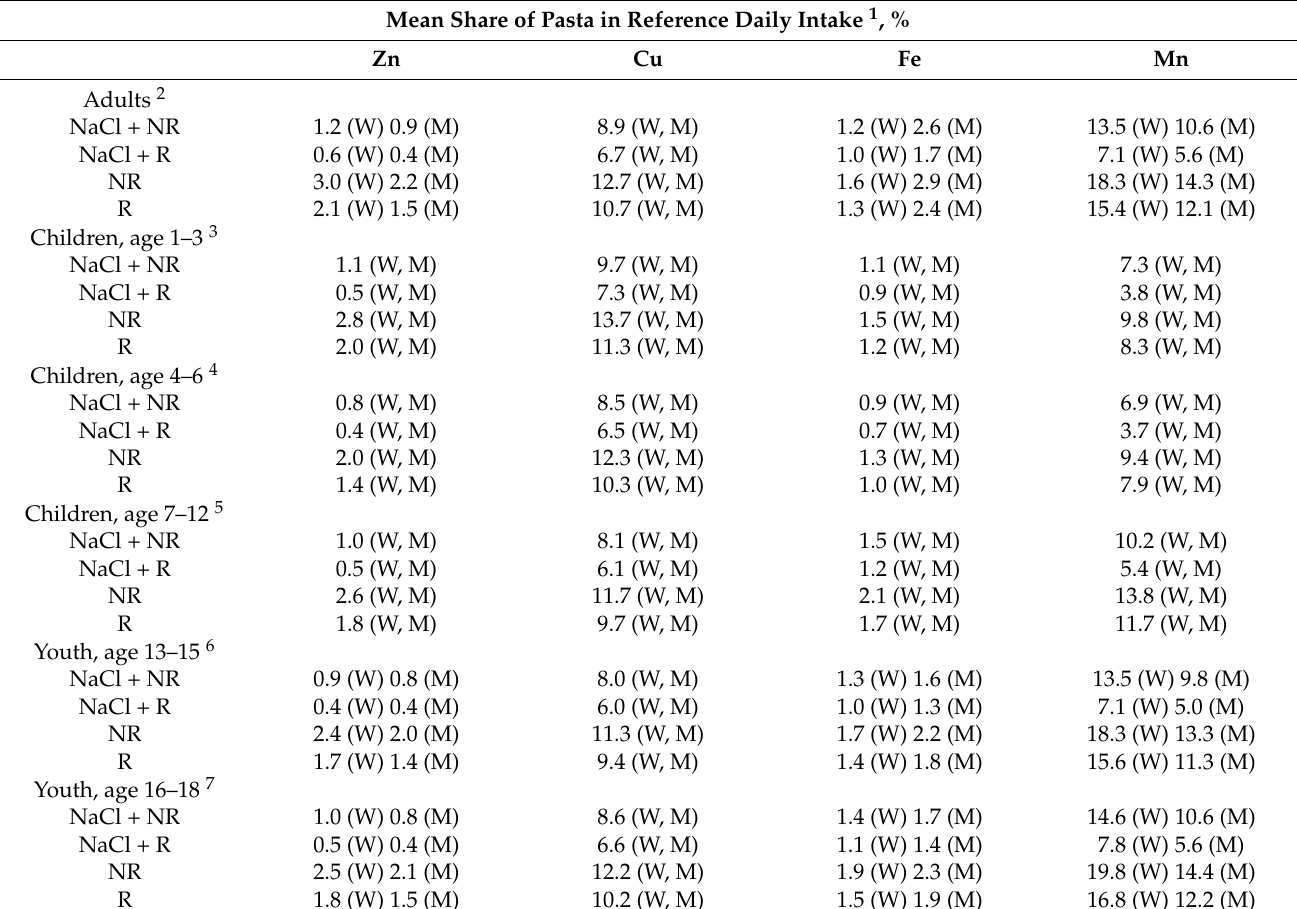
Table 6. Share of pasta products in the supply of Zn, Cu, Fe, and Mn in the diets of respective groups of Poles. Mean Share of Pasta in Reference Daily Intake 1 , % Zn Cu